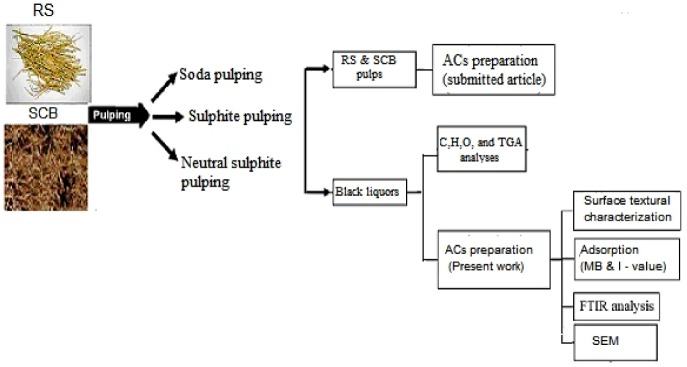
Experimental work.